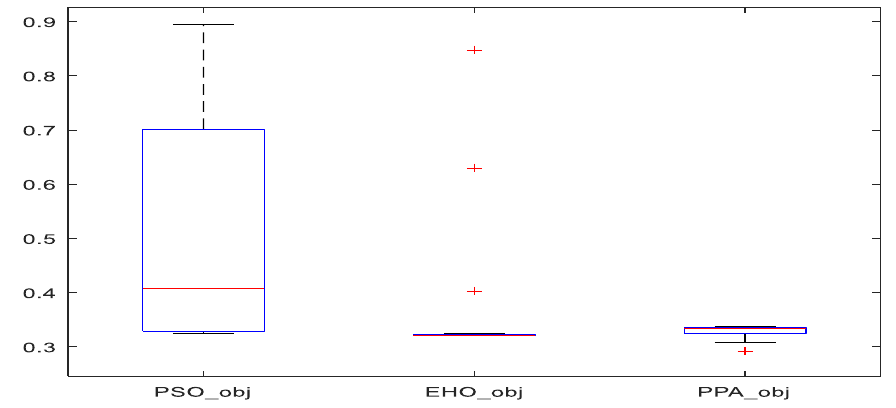
Figure 13. Box plot for the objective function of the final generation population for every optimization technique.